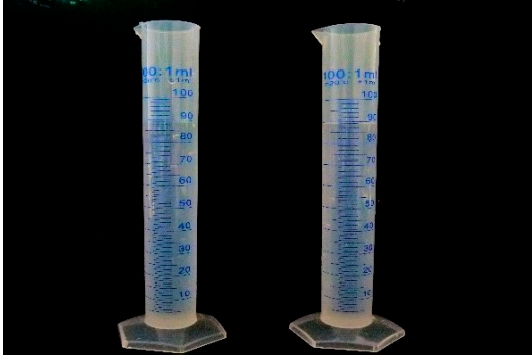
Figure 11. Measuring cylinder used.